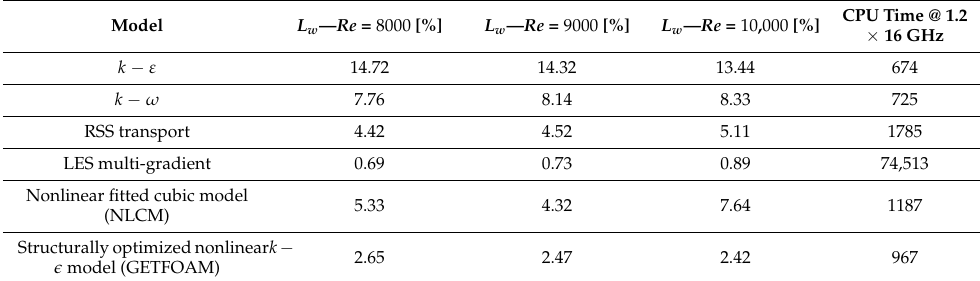
Table 3. Errors and computation time of each turbulence model for the Low Aspect Ratio Backward Facing